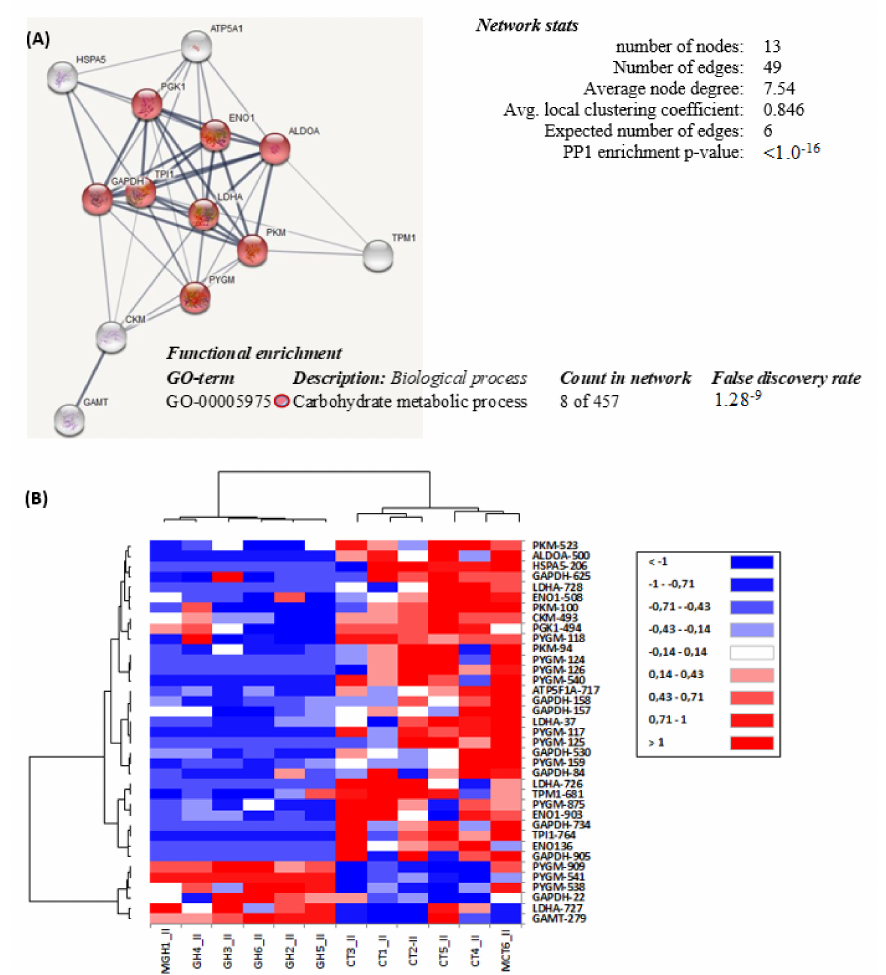
Figure 3. White muscle proteomic profile of differentially expressed proteins between rbGH group and control group of gilthead sea bream. ( A ) The network analysis of protein–protein interactions among proteins grouped into 1 functional category, according to Gene Ontology enrichment analysis by GOEAST. In this network, nodes are proteins, the thickness of the lines indicates the degree of confidence prediction of the interaction, according to the STRING databases. The average of local clustering coefficient was 0.846 for “Carbohydrate metabolic process” (GO: 0005975, p -value: 1.0 − 16 ) (see Supplementary materials: Table S1). ( B ) Heat map of the hierarchical clustering of the relative abundance of differentially expressed proteins between the white muscle of rbGH group and control group (Perseus program). Every line represents one independent sample of each group, while the different protein spots are represented by individual rows. Red indicates high levels of expression while blue represents low levels. The intensity of the colours represents the relative abundance. Raw data of each spot are included in Supplementary materials (Table S2). Protein acronyms correspond to Gene Symbol (see Table 5 for